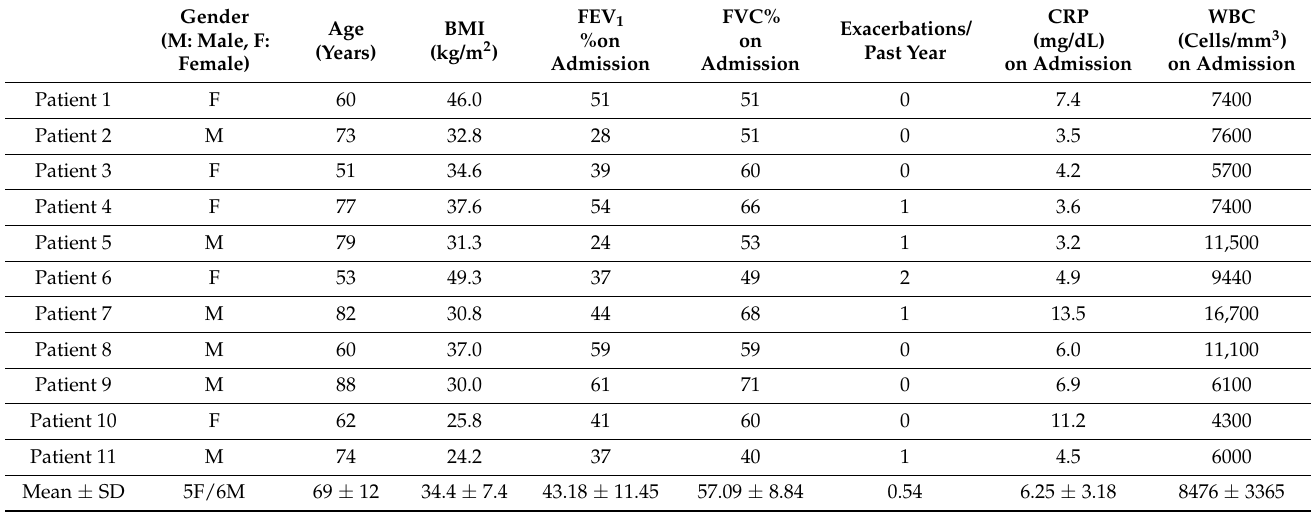
Table 1. Demographic and clinical characteristics of the patients of the study treated with